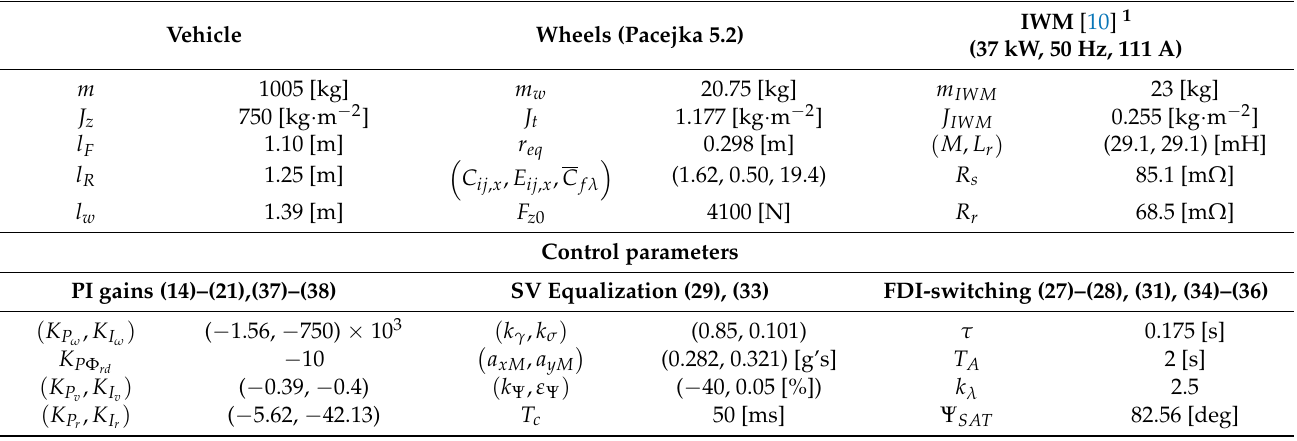
Table 2. Vehicle, Wheels, IWMs and Control